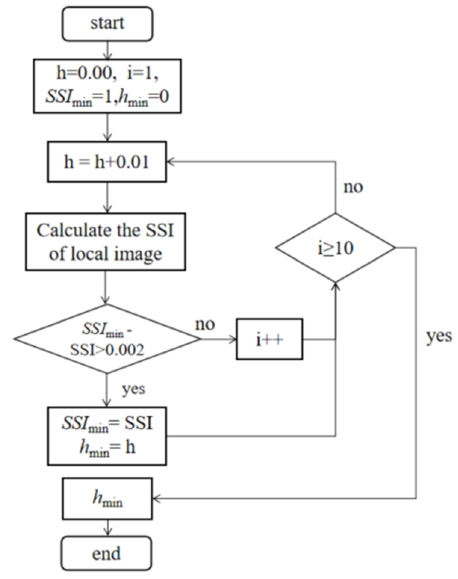
Figure 6. SSI-based adaptive h-solving method.